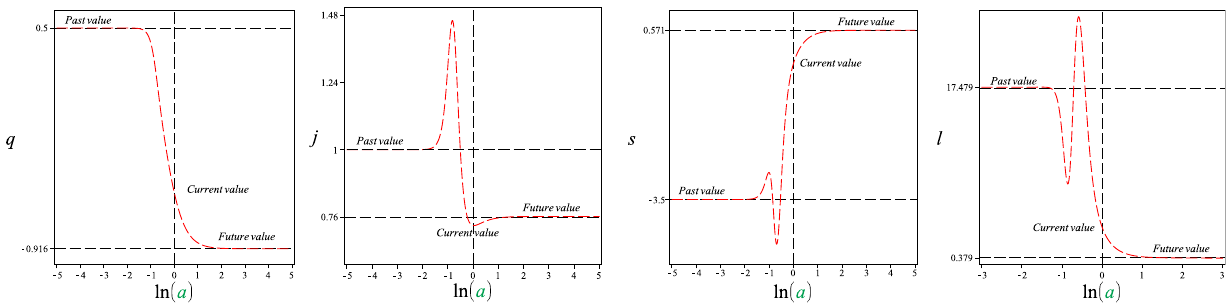
variables to simplify the obtained equations (χ, ζ) . There are